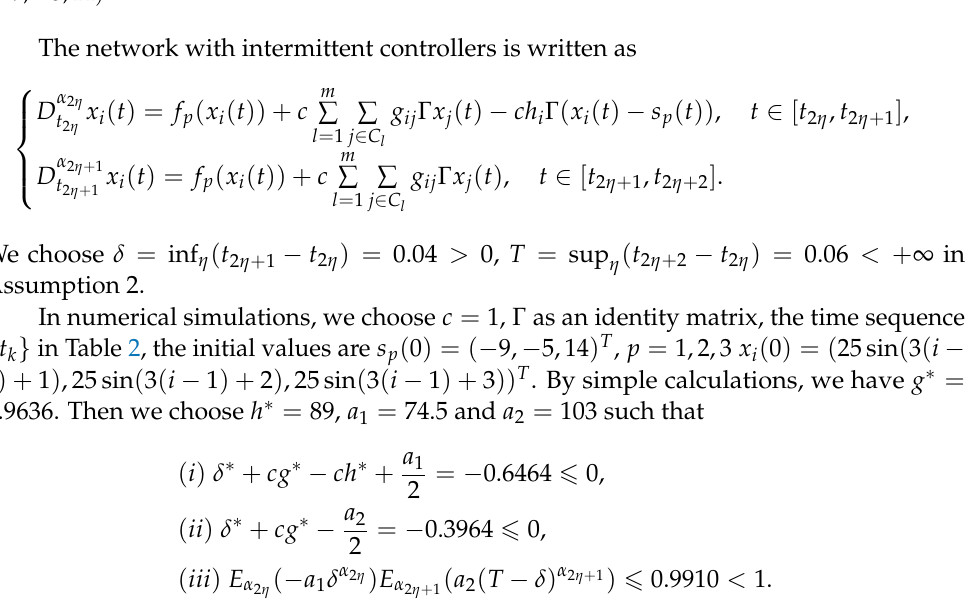
Figure 3. The chaotic behavior of variable-order fractional Chen system (System (8)) with x i ( 0 ) = ( − 9, − 5,14 ) T